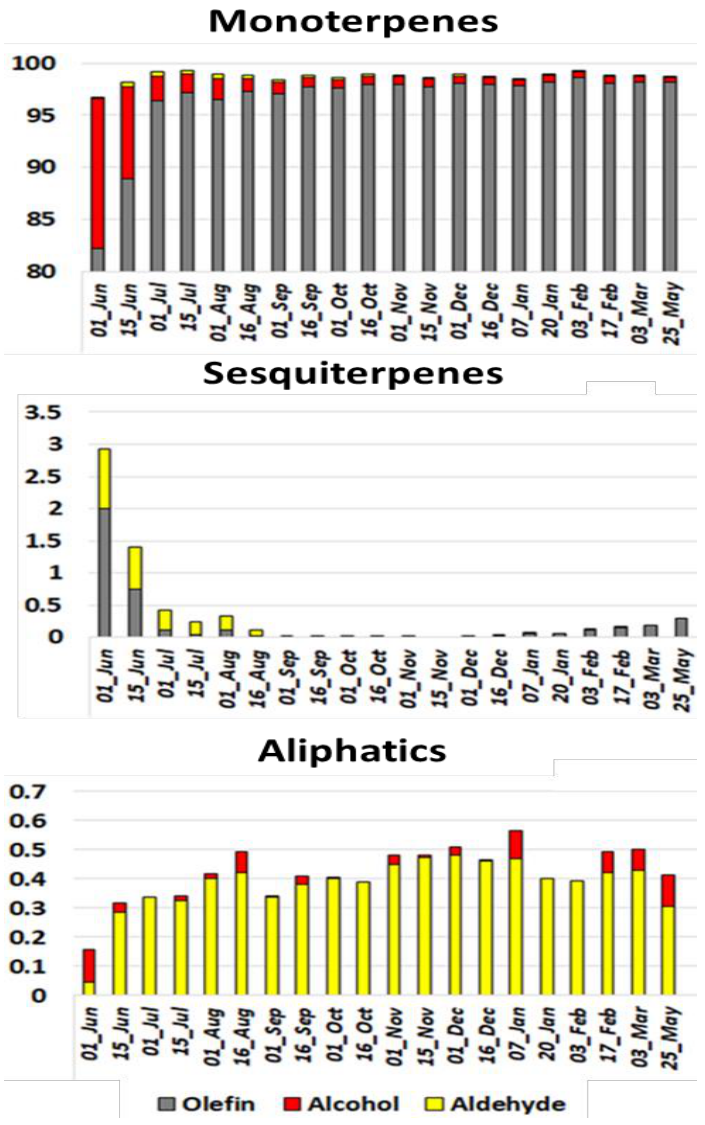
Figure 3. Stacked bar plot representing the mean proportion of major chemical families of the “Cara Cara navel” sweet orange cultivar during fruit development.